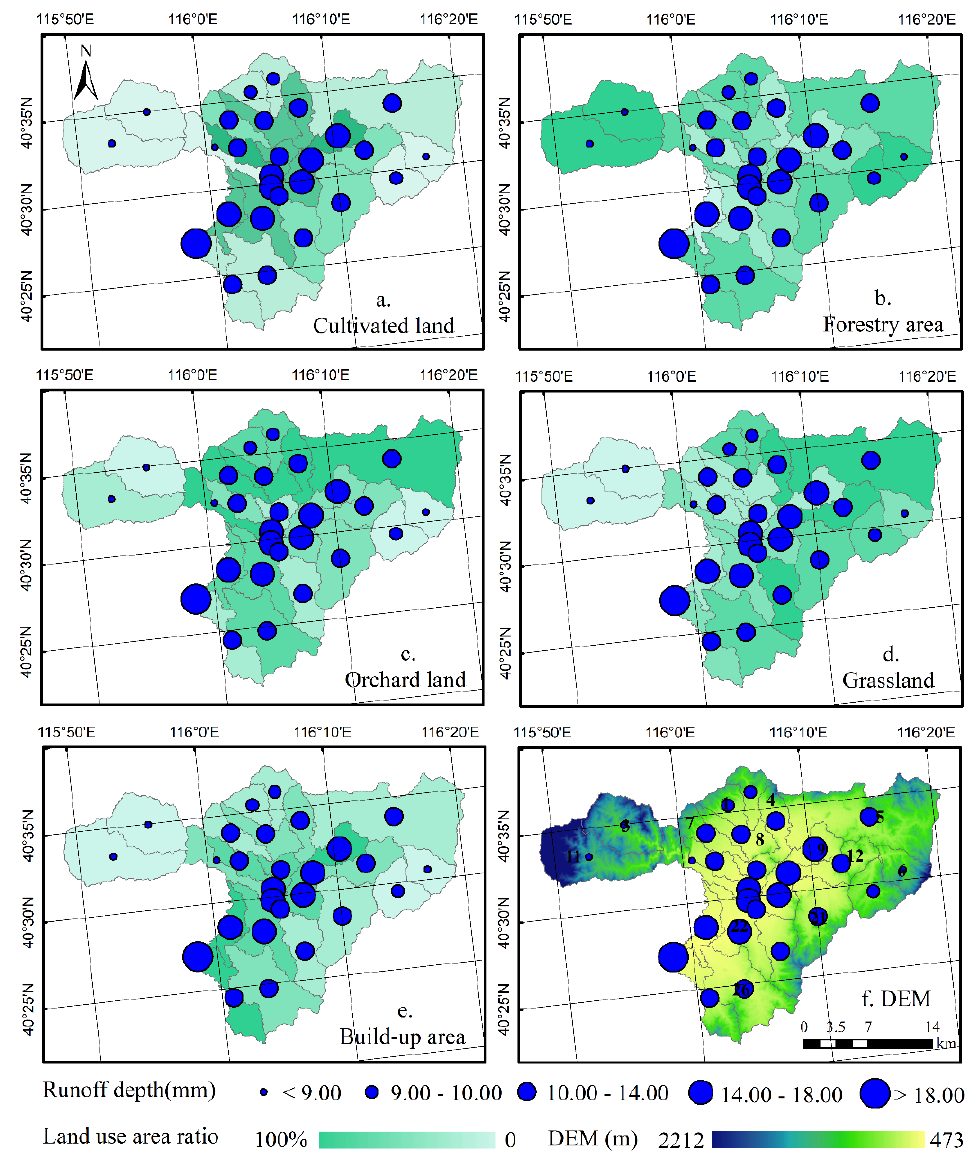
Figure 5. Spatial distribution of annual average runoff depth in the Guishui River Basin.